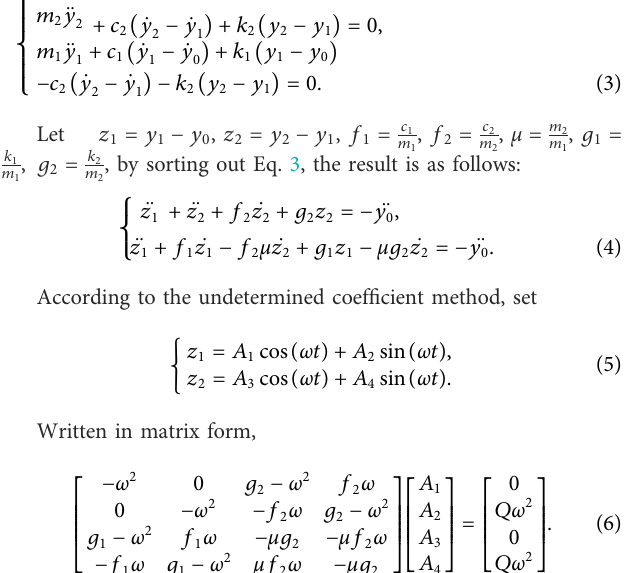
FIGURE 4 Vehicle vibration